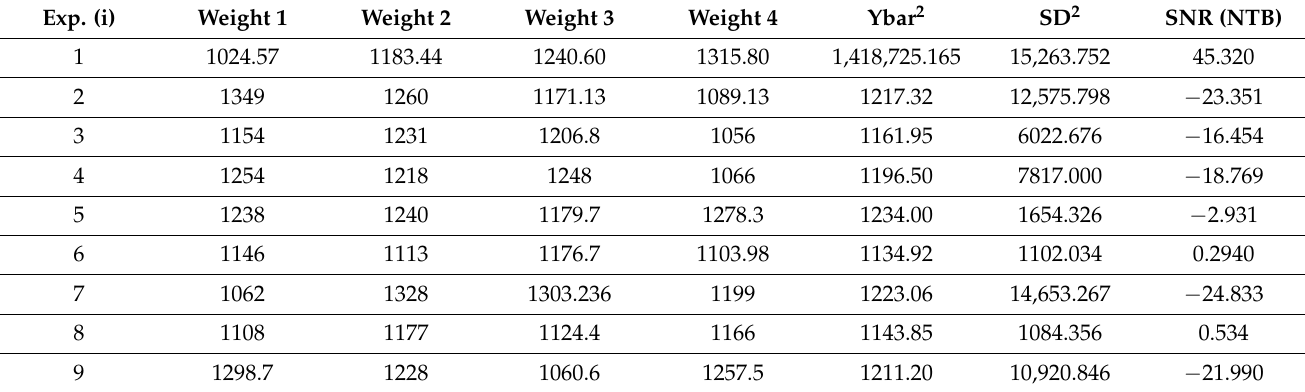
Table 5. SNR for the 4 runs of the 9 experiments for the weight (g) response.